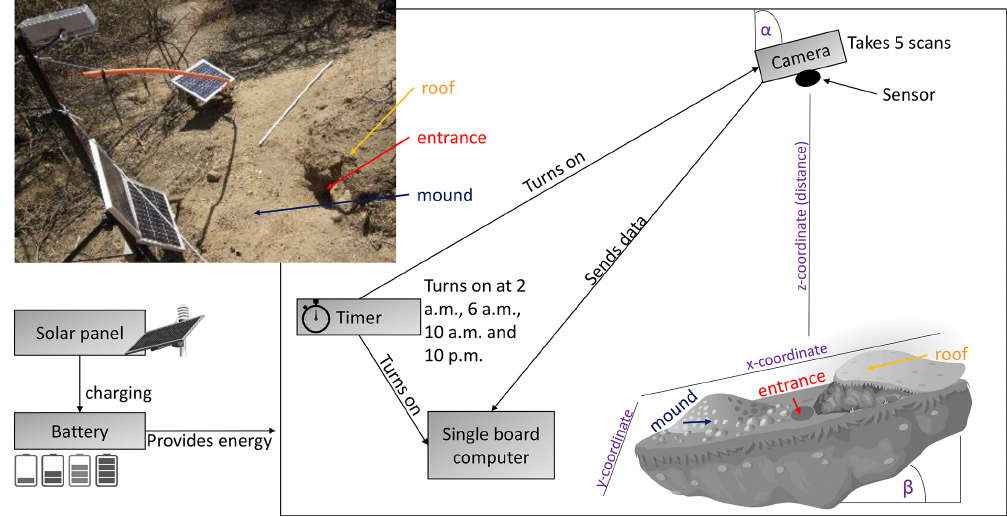
Figure 3. Scheme and photo example of a time-of-flight-based camera installation in the field. The photo example is from north-facing upper hillslope at La Campana. Black boxes describe single installation parts. Purple descriptions are the variables needed for the correction of the scans. Roof, entrance, and mound describe parts of the burrow. The x , y , and z coordinates are 3D coordinates identifying the position of each point in space, where the x coordinate is the length, the y coordinate is the width, and the z coordinate is the distance between the camera sensor and the surface. α is the inclination of the camera, and β is the surface inclination.